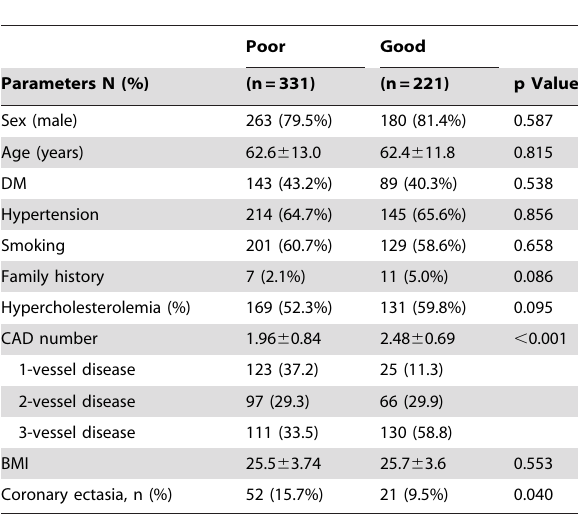
Table 5. Multivariate logistic regression analysis of collateral circulation in whole population (poor collateral group as reference